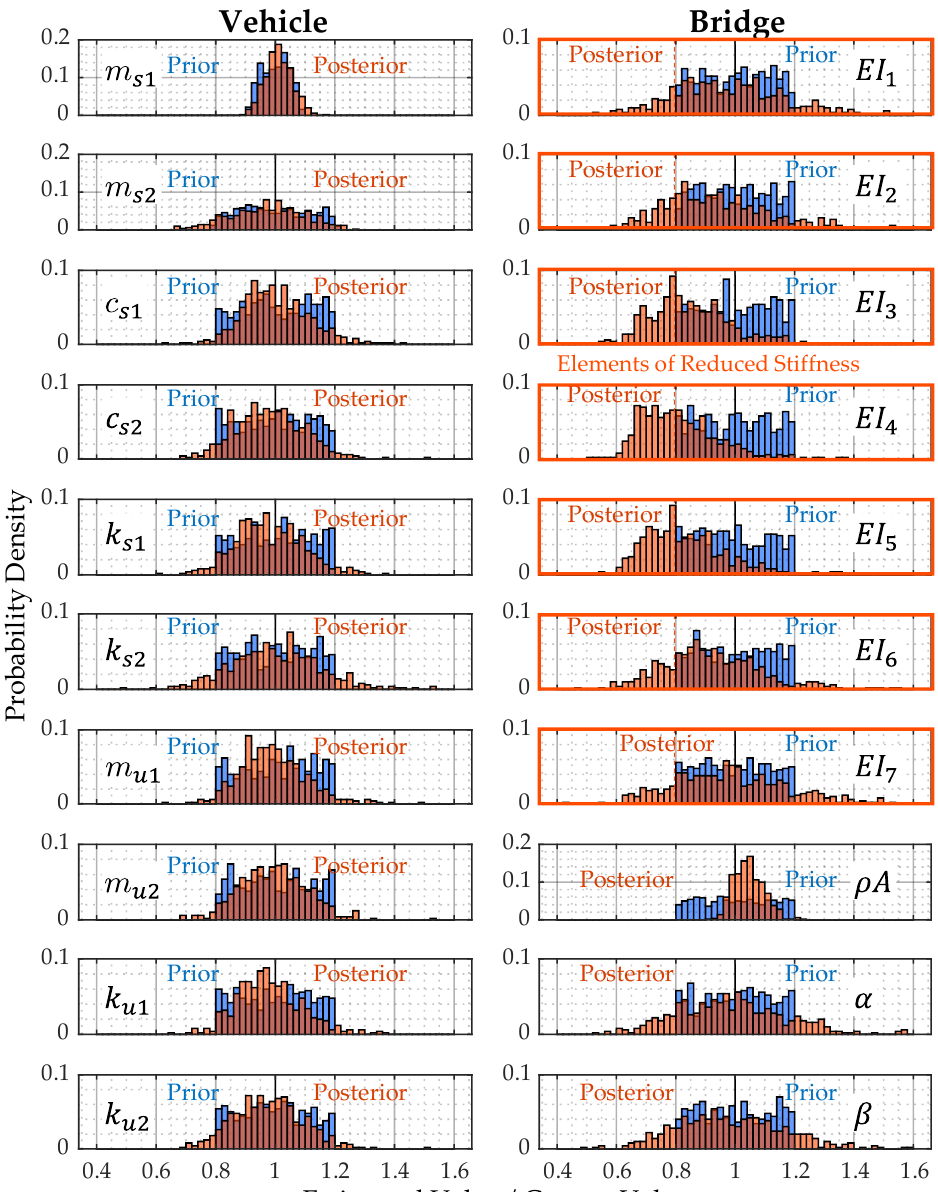
Figure A6. The application results of the PRE method in the case of Scenario 3 (stiffness decrease section: 0 ~ 𝐿 , decrease rate: 20%).